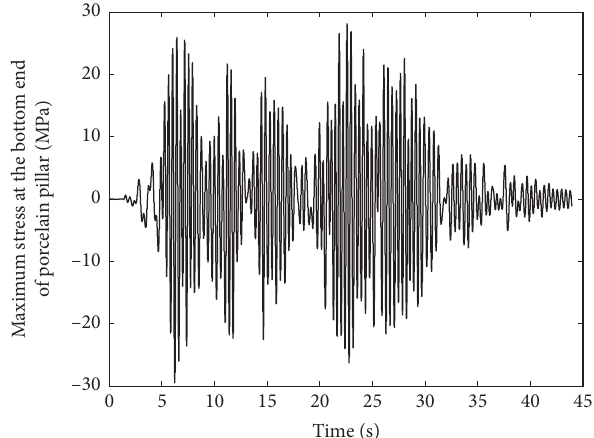
Figure 22: Displacement at the top of porcelain pillar ( a � 0.3g, η � 20,000).